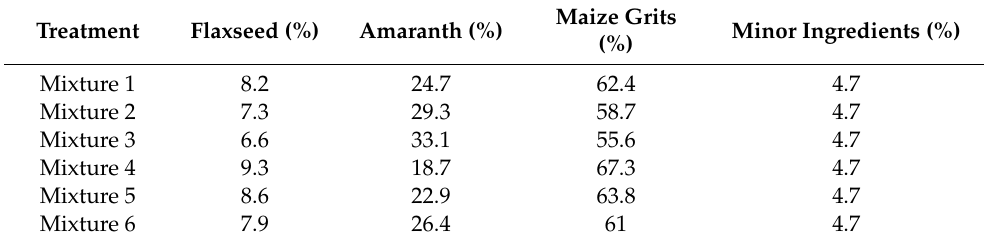
Maize Grits Minor Ingredients (%) (%)